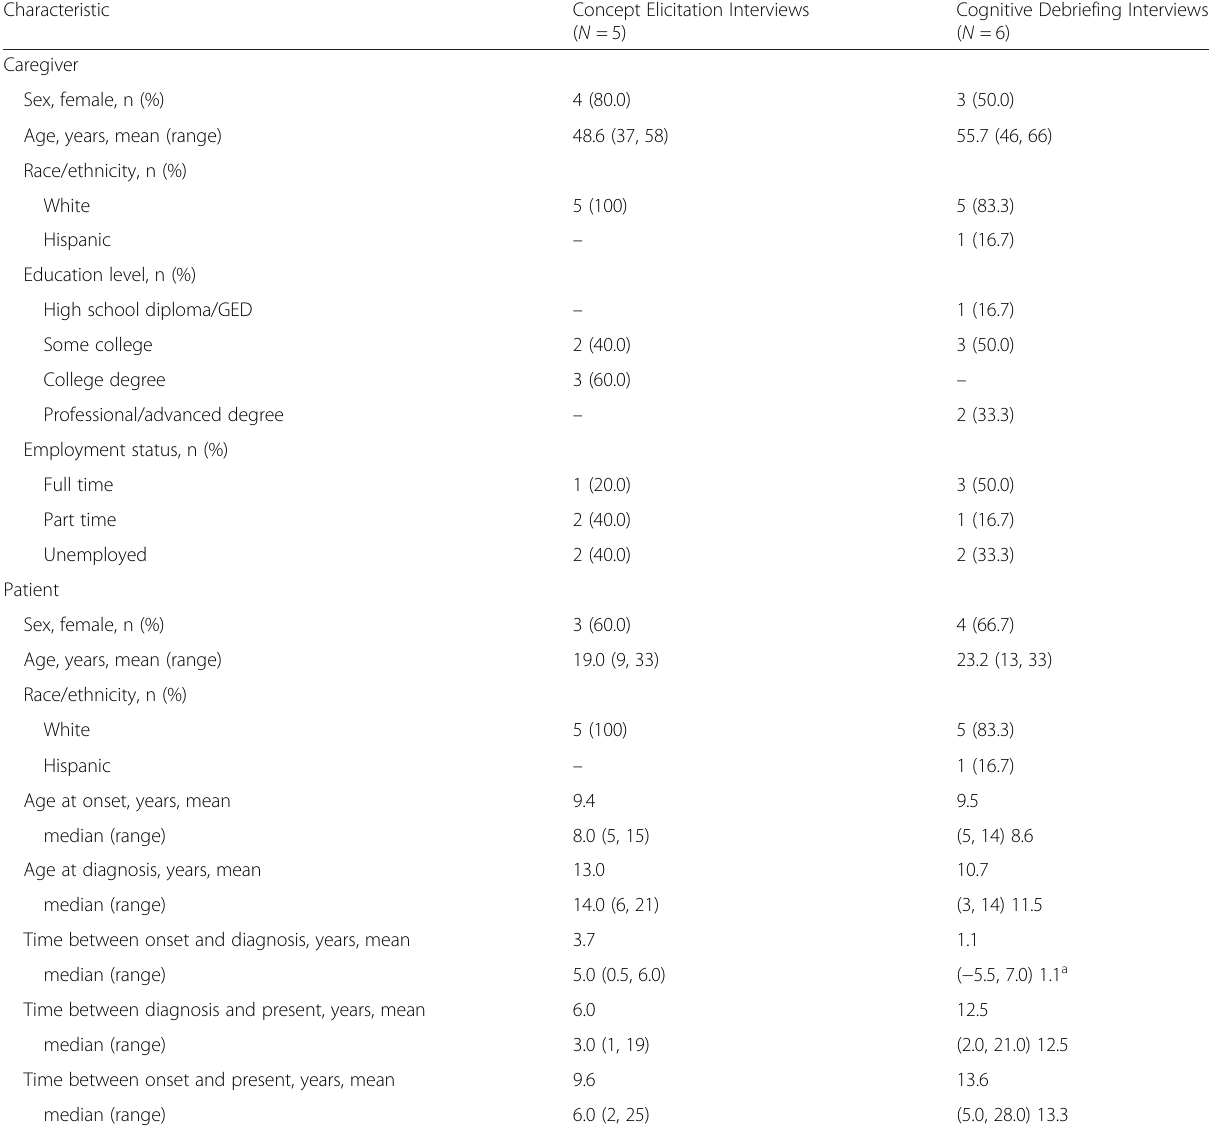
Table 1 Caregiver and Patient